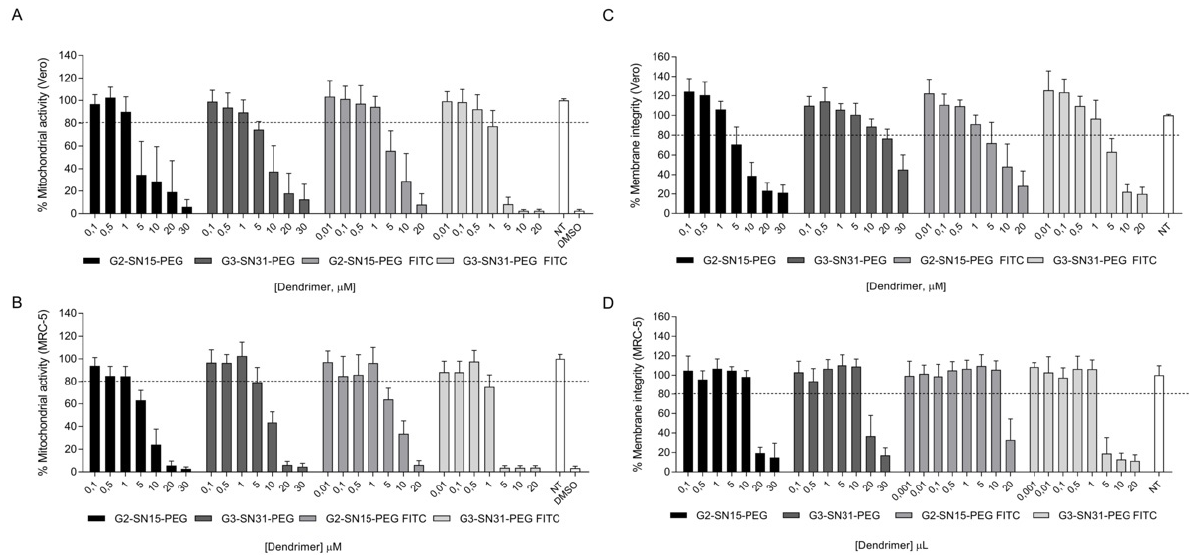
Figure 1. Cytotoxicity of dendrimers by 3-(4-5-dimethylthiazol-2-yl)-2,5-diphenyltetrazolium bro- mide (MTT) and lactate dehydrogenase (LDH) assay. ( A , B ) MTT assay; ( C , D ) LDH assay. ( A , C ) Vero and ( B , D ) MRC-5 cells were treated with increasing concentrations of dendrimers G2-SN15-PEG, G3-SN31-PEG, G2-SN15-PEG fluorescein isothiocyanate (FITC) labeled and G3-SN31-PEG FITC from 0.01 to 30 µ M. Non-toxic concentrations were established when cell viability was ≥ 80%. Culture medium was used as cell viability control and DMSO 10% was used as death control. Data are represented as mean ± SD of three individual experiments performed in triplicate. NT: non-treated; DMSO: dimethyl sulfoxide.